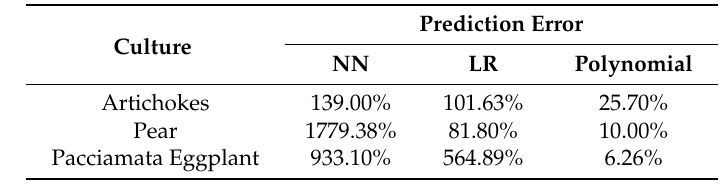
Table 6. Task 2: comparison on the prediction error for the cultures leaf area index (LAI) value exploiting machine learning methods on the CNR scientific agrarian dataset.